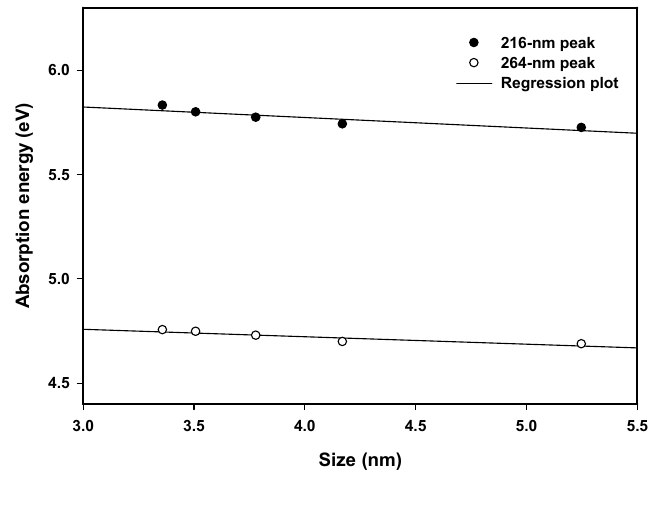
Figure 10. Absorption energy of Pt nanoparticles decreased from 5.83 to 5.72 eV for the first peak and from 4.75 to 4.69 for the second peak with increasing particle size from 3.4 to 5.3 nm which corresponds to the change of absorption peak from 212.7 to 216.6 nm for the first peak and from 260.9 to 264.6 nm for the second